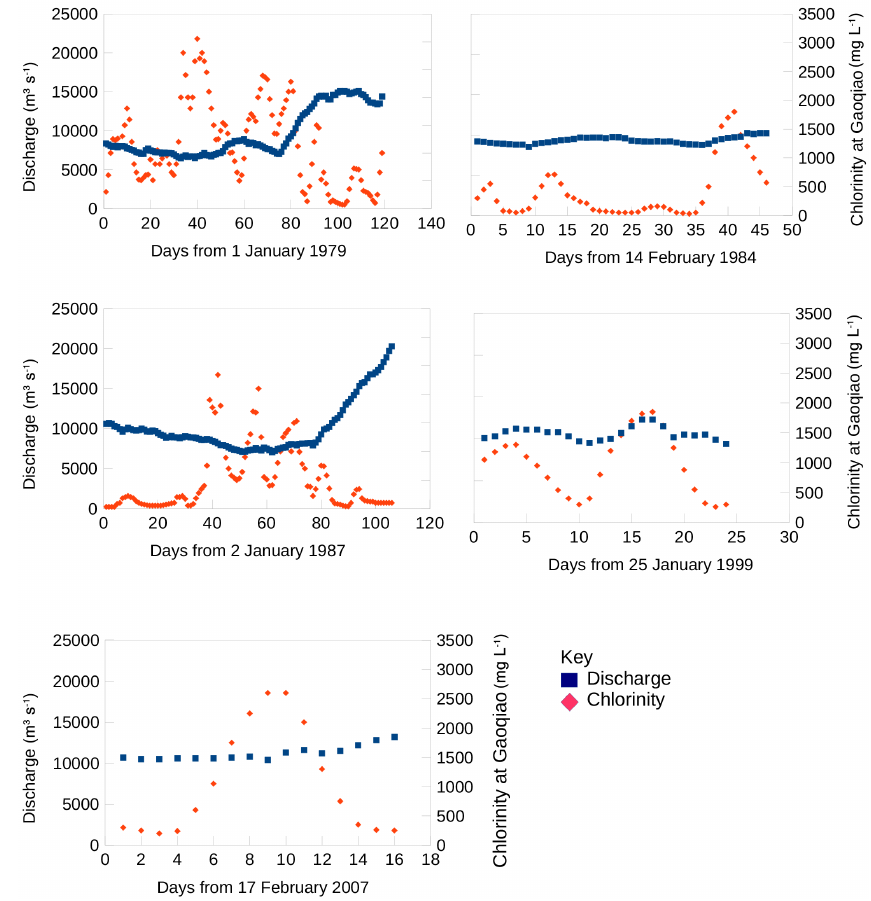
Figure 2. Chlorinity and discharge conditions in the periods of